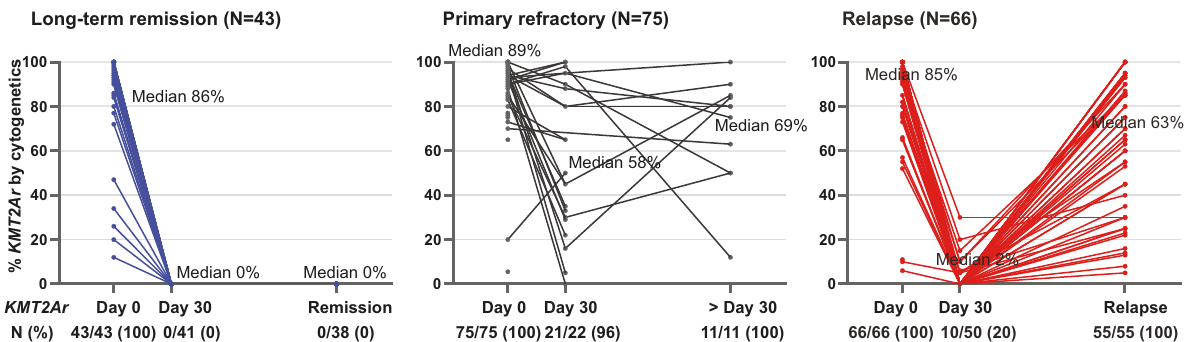
Fig. 2 Dynamic changes of the cytogenetic burden in adults with KMT2Ar AML following treatment. Numbers depict the estimated % of KMT2Ar measured by fl uorescence in situ hybridization (FISH) or conventional cytogenetics when FISH was not performed. Numbers below the X-axis indicate the proportion (%) of patients with KMT2Ar among those with available cytogenetic data. This analysis included unique patients from the newly diagnosed cohort in addition to patients who presented to our institution with relapsed or refractory disease. The long-term remission graph depicts those who achieved and maintained a morphologic remission whereas the relapse graph depicts those with initial morphologic remission following induction treatment and subsequent relapse.